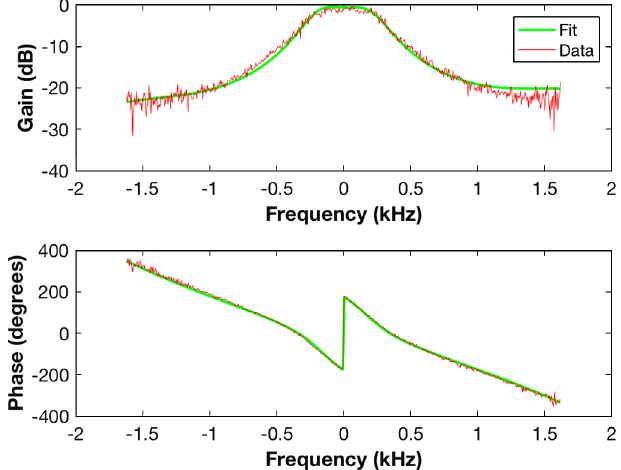
FIG. 7. LHC Cavity 1B1 measured and modeled closed loop transfer function ( Q L ¼ 20000